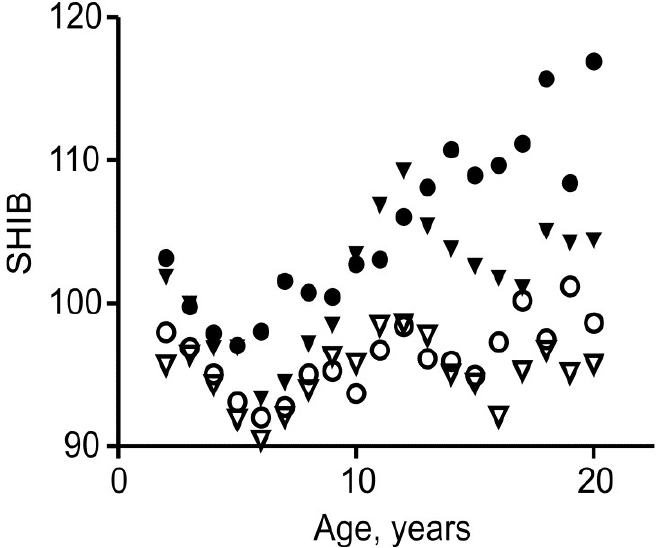
Figure 1. A plot of the sitting-height index of build, (body mass)/(sitting height) 3 (SHIB), against age for white females ( ○ ), black females (●), white males ( ), and black males ( ▼ ).